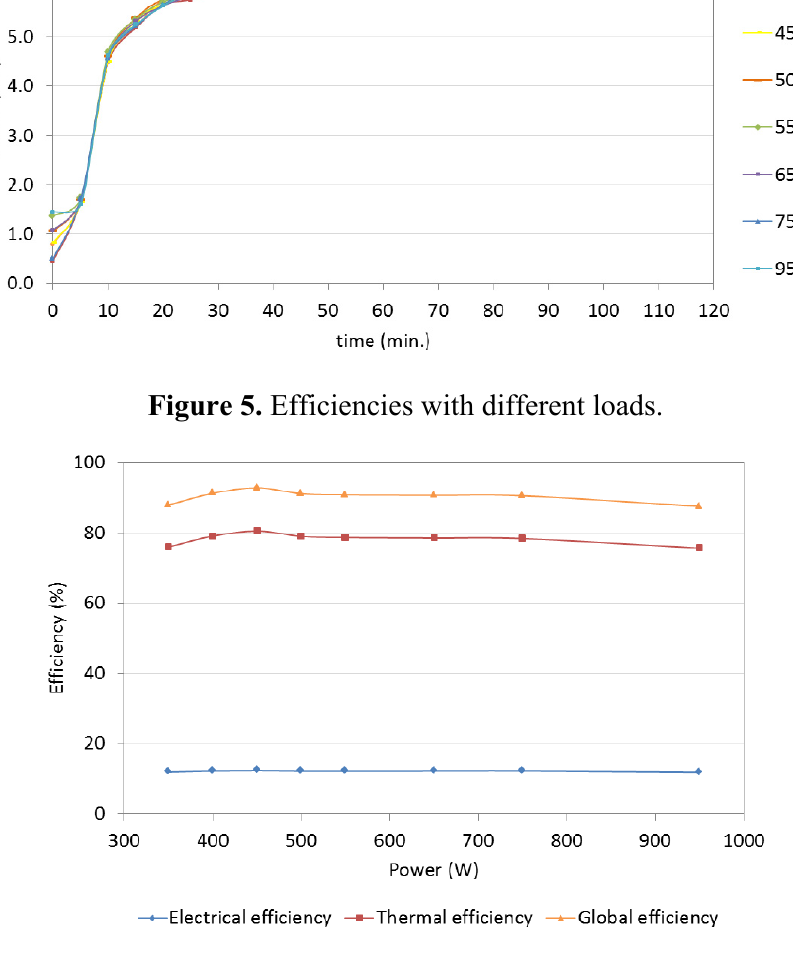
Table 2. Thermal properties of the layers of the walls and roof.